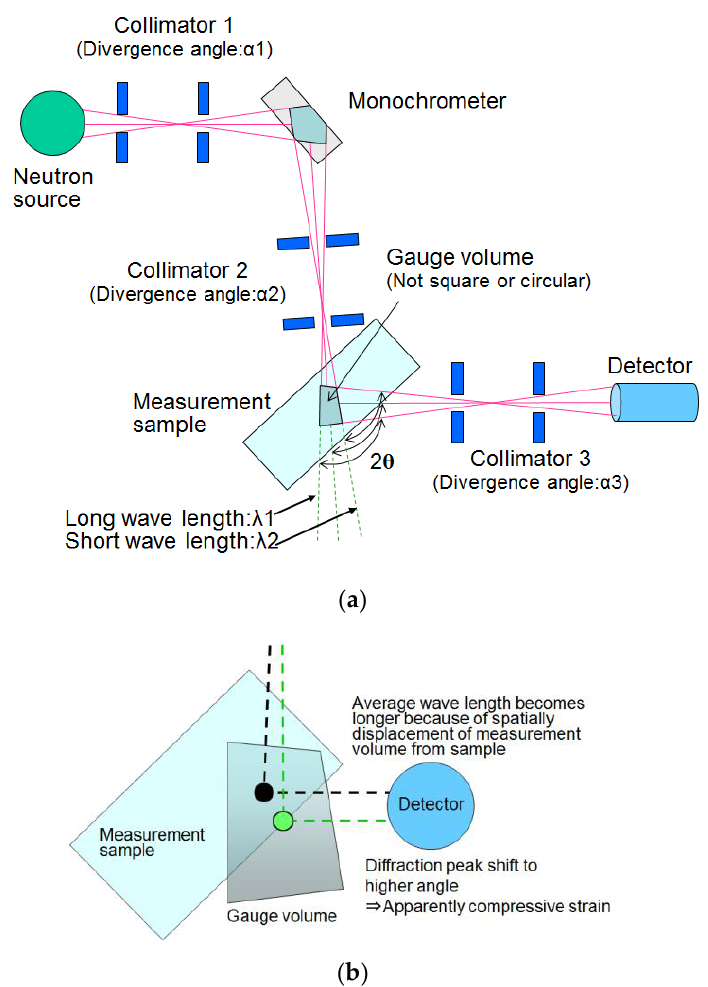
Figure 6. Principle of pseudo peak shift occurrence in neutron diffraction. ( a ) Total optics in neutron diffraction; ( b ) optics around gauge volume.